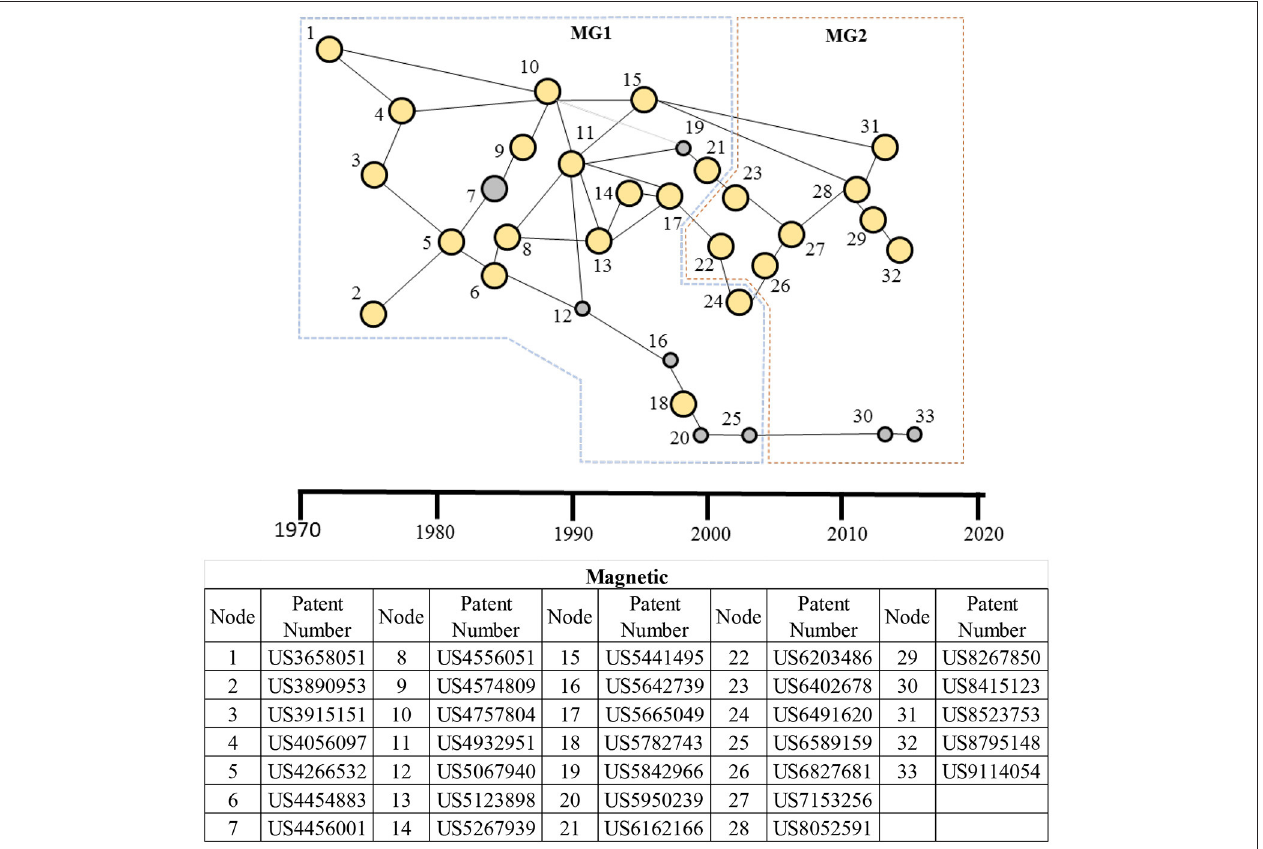
FIGURE 7 | Main paths for the magnetic therapeutic domain. MG1: A patent cluster for stimulation of tissue/bone growth; and MG2: a patent cluster for transcranial brain stimulation. The table presents details of each patent in the main paths. High-persistence patents are shown as bigger yellow circles, whereas the low-persistence patents are shown as smaller gray